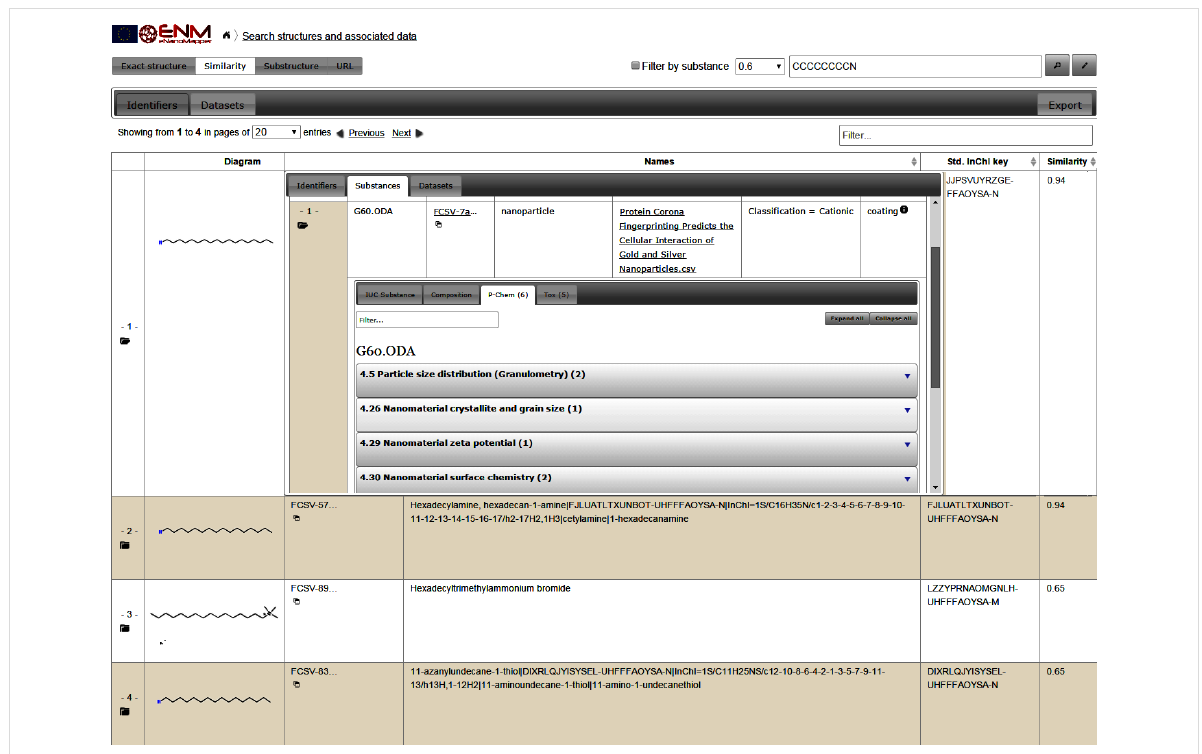
Figure 13: Screenshot showing the results of a chemical similarity query (octyl amine, SMILES CCCCCCCCN) with a similarity threshold Tanimoto coefficient = 0.6. The results include octadecylamine (similarity 0.94), hexadecylamine (similarity 0.94), hexadecyltrimethylammonium bromide (simi- larity 0.65), 11-amino-1-undecanethiol (similarity 0.65), all used as coating of silver and gold nanoparticles in the protein corona dataset. The first row shows expanded view with details of the NM.